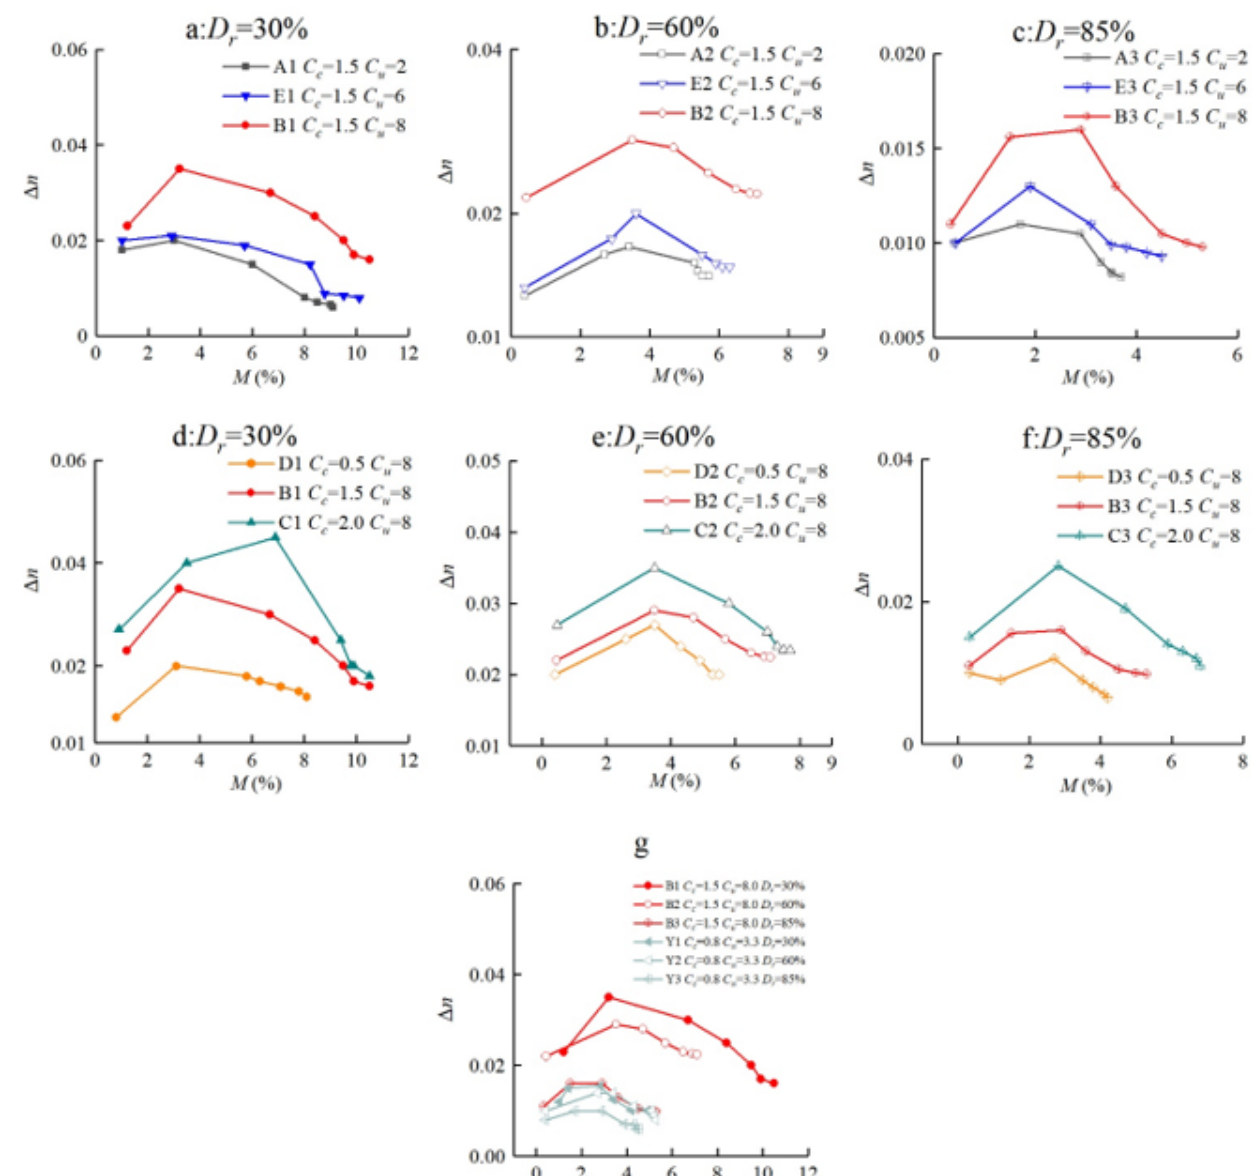
Figure 7. Permeability coefficient difference ( Δ k) vs. cycles of MICP treatment (MT) of sand at dif- ferent gradations and compactness ( D r ): ( a ) D r = 30% for samples A1, B1 and E1; ( b ) D r = 60% for samples A2, B2 and E2; ( c ) D r = 85% for samples A3, B3 and E3; ( d ) D r = 30% for samples B1, C1 and D1; ( e ) D r = 60% for samples B2, C2 and D2; ( f ) D r = 85% for samples B3, C3 and D3; ( g ) samples B and Y.